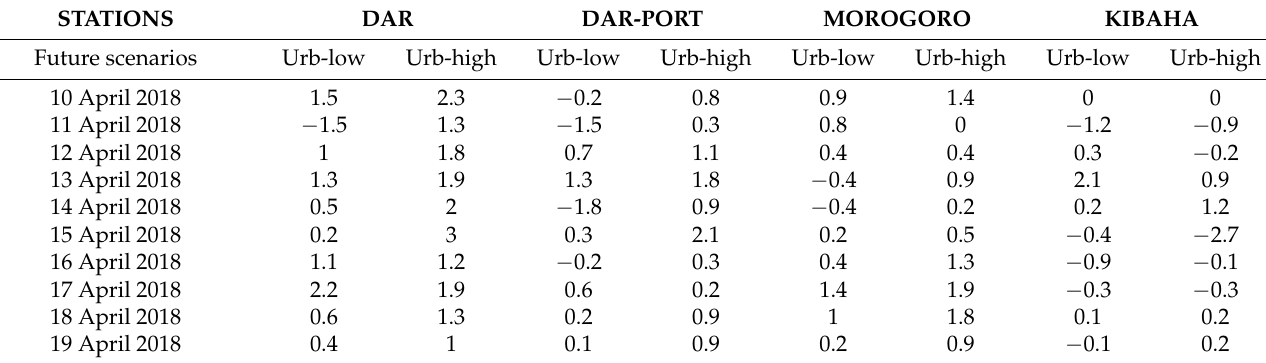
Table 6. Daily maximum air temperature difference ( ◦ C) for urbanization scenarios from the current LULC at four stations. STATIONS DAR DAR-PORT MOROGORO KIBAHA Future scenarios